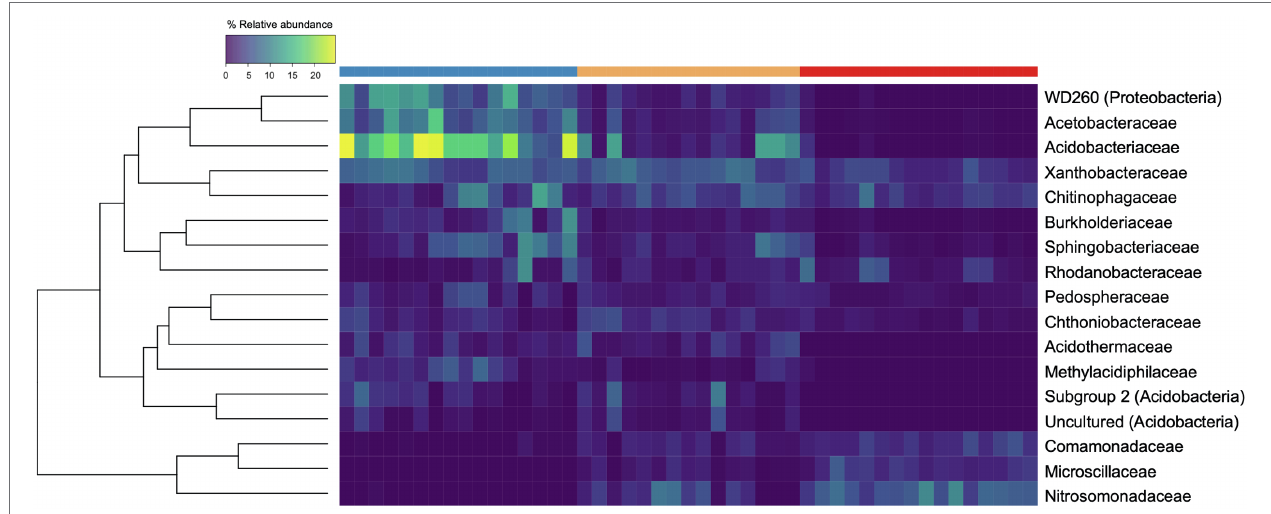
FIGURE 3 | Heatmap of bacterial families present at maximum abundances greater than 5%. Each row corresponds to a family, and each column corresponds to an individual soil core community. The top row signifies the level of soil disturbance of each core with blue = undisturbed (UD; n = 16), gold = semi disturbed (SD; n = 15), and red = most disturbed (MD; n = 16). The rows are clustered by Bray-Curtis distance and the color of each box displays the relative abundance of the taxon within that core.